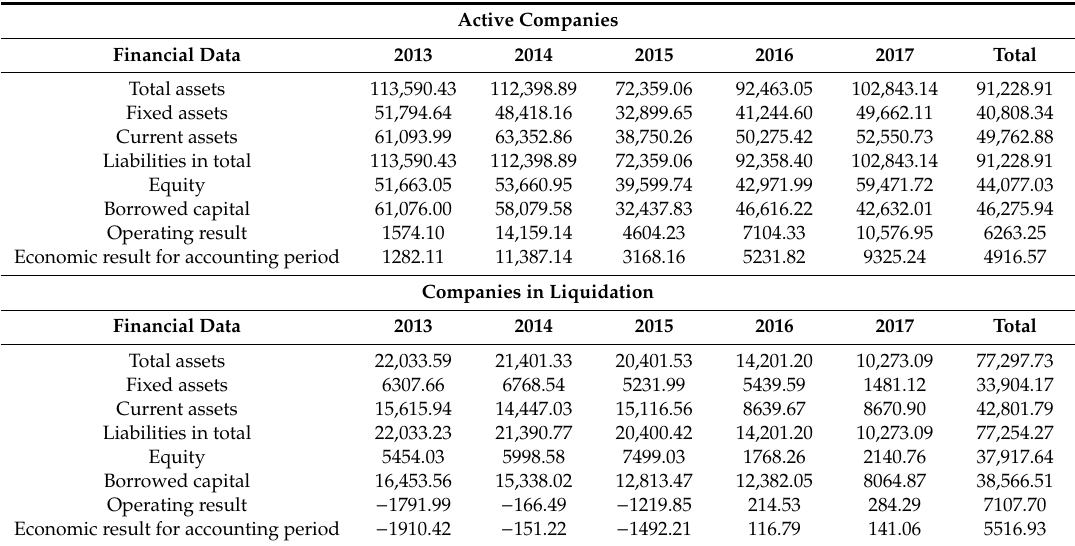
Table 1. Selected financial data of data